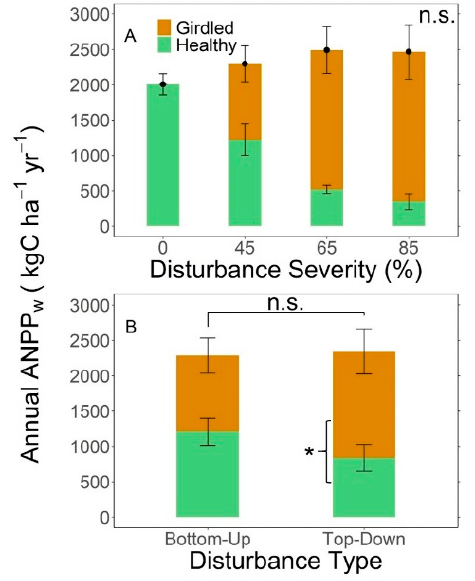
Figure 5. Contributions of girdled and healthy upper canopy ( ≥ 8 cm DBH) trees to annual aboveground wood net primary production (ANPP w , ± 1 S.E.) in the control and among disturbance severity ( A ) and disturbance type ( B ) treatments. Healthy and girdled refers to the fraction of ANPP w supplied by each within a disturbance severity ( A ) and disturbance type ( B ) category. Error bars are the SE of mean annual ANPP w among treatment replicates. While significant differences were not detected among treatments (n.s), the asterisk denotes that within disturbance types, girdled trees contributed more to ANPP w in the top-down relative to the bottom-up disturbance treatment ( B ; α = 0.05).